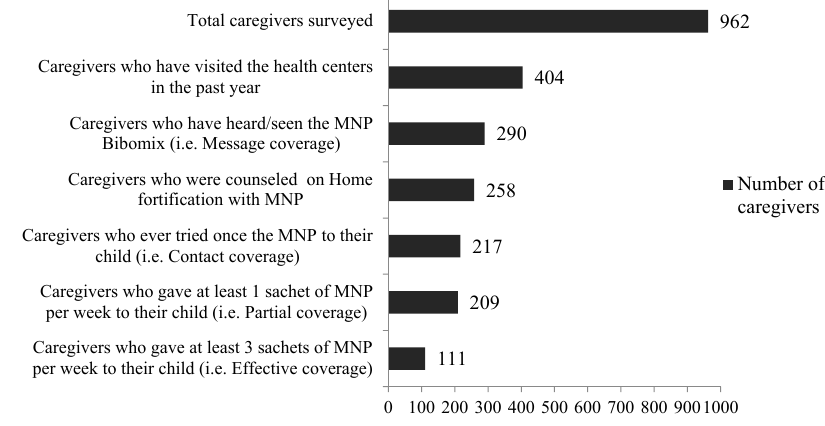
Figure 4. Caregivers visit and counseling at the health centers and MNP coverage.